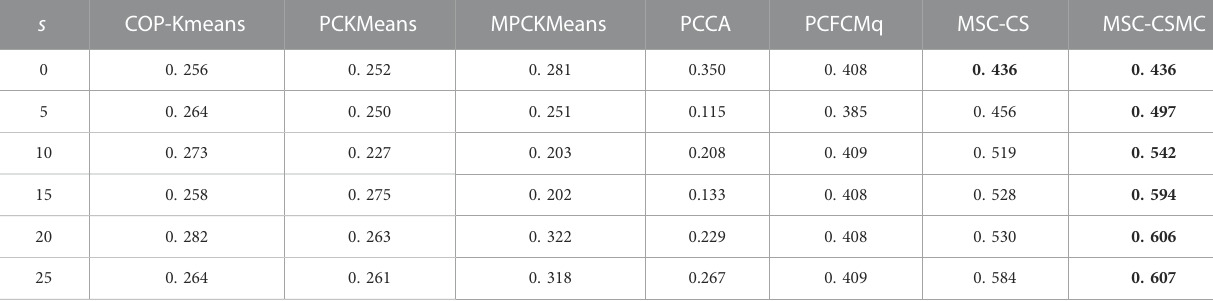
The bold values indicate the optimal solutions in each row.